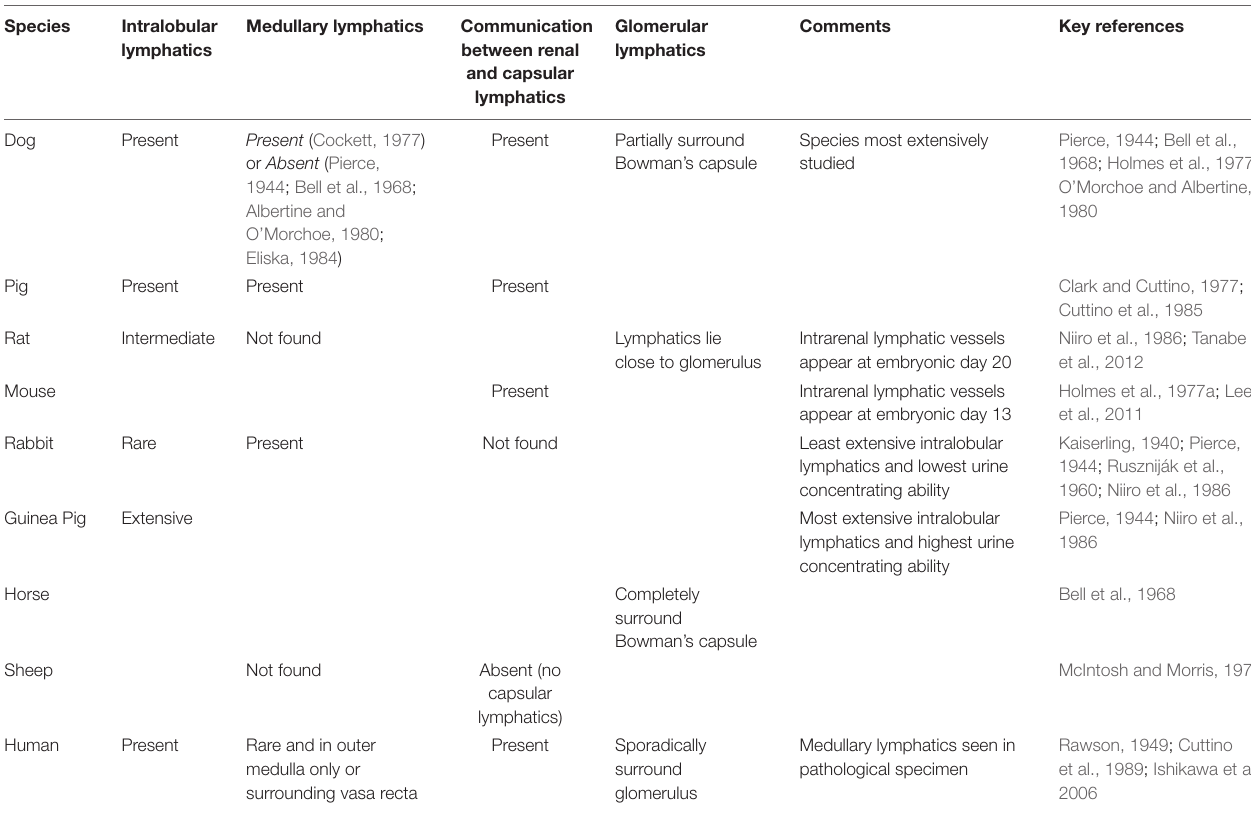
TABLE 1 | Comparison of renal lymphatic anatomy between